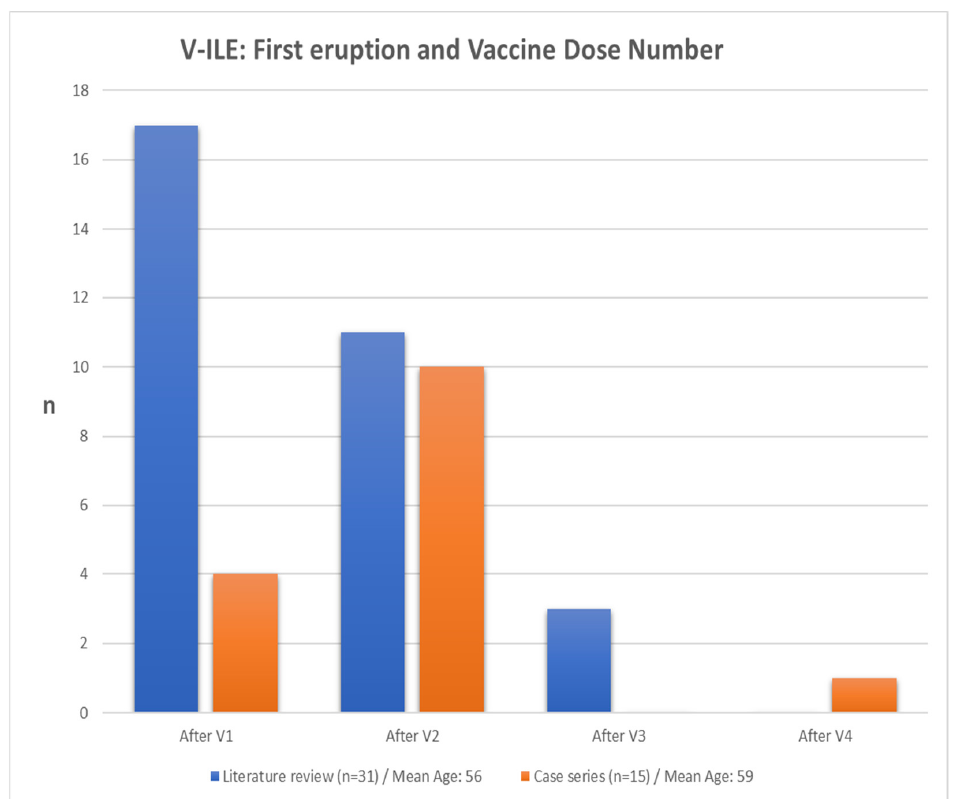
Figure 15. Number of cases from the case series and literature review experiencing first eruption and corresponding vaccine dose number. n, number of cases; V1, first dose of vaccine; V2, second dose of vaccine; V3, third dose of vaccine; V4, fourth dose of vaccine.